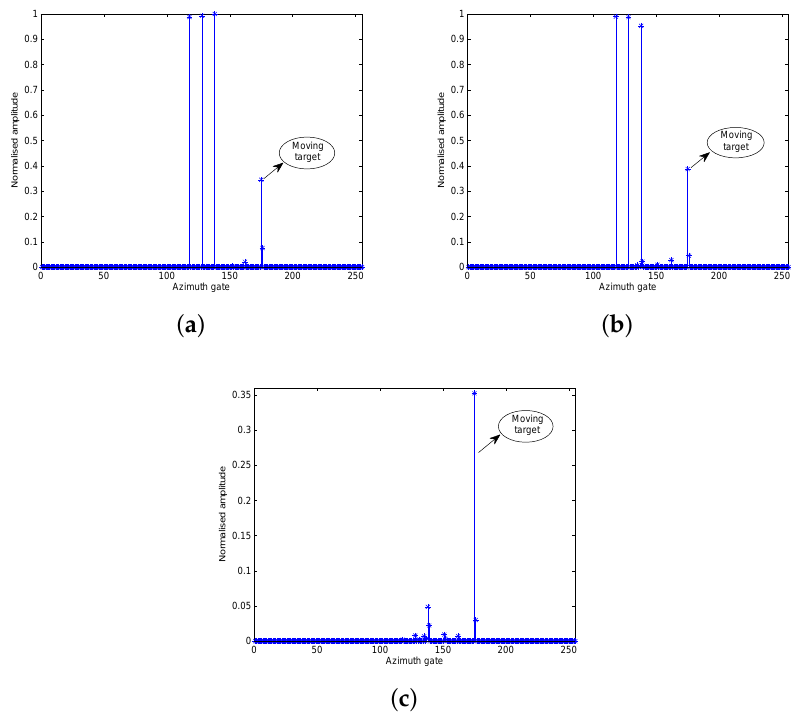
Figure 12. CS-based reconstruction results: ( a ) channel 1 with data rate 50% in azimuth; ( b ) channel 2 with data rate 50% in azimuth; ( c ) DPCA with data rate 50% in